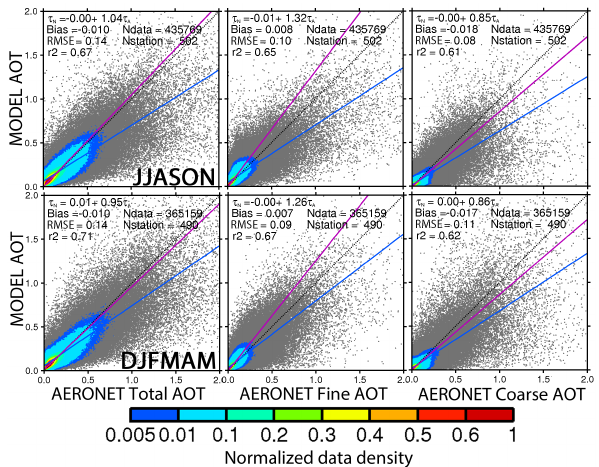
Figure 7. Pairwise comparison of the global 6-hourly reanalysis AOT and AERONET AOT with respect to total (left), fine (middle) and coarse (right) modes at 550nm for JJASON (upper) and DJF- MAM (bottom) for the entire reanalysis time (2003–2013). The nor- malized data density is shown in color. The solid magenta line rep- resents a Theil–Sen linear regression and the corresponding equa- tion is shown, where τ N is the NAAPS reanalysis AOT and τ A is the AERONET AOT. The solid blue line is a least-squares linear regres- sion and the corresponding equation is not shown. Also shown are the bias, root mean square error (RMSE), square of the Pearson’s correlation coefficient ( r 2 ) , total number of stations (Nstation) and total number of 6-hourly AERONET data